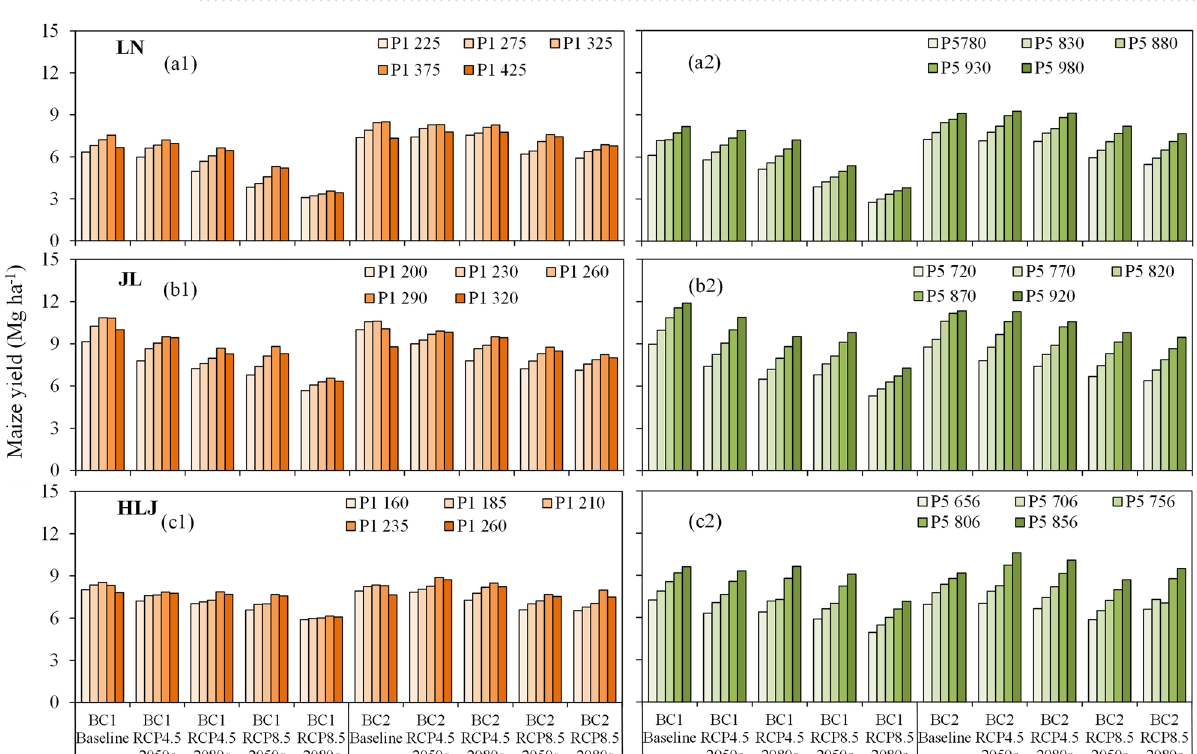
Figure 4. Responses of maize yields to cultivar parameters P1 ( a1 , b1 , c1 ) and P5 ( a2 , b2 , c2 ) under climate change scenarios at Liaoning (LN), Jilin (JL) and Heilongjiang (HLJ) provinces in Northeast